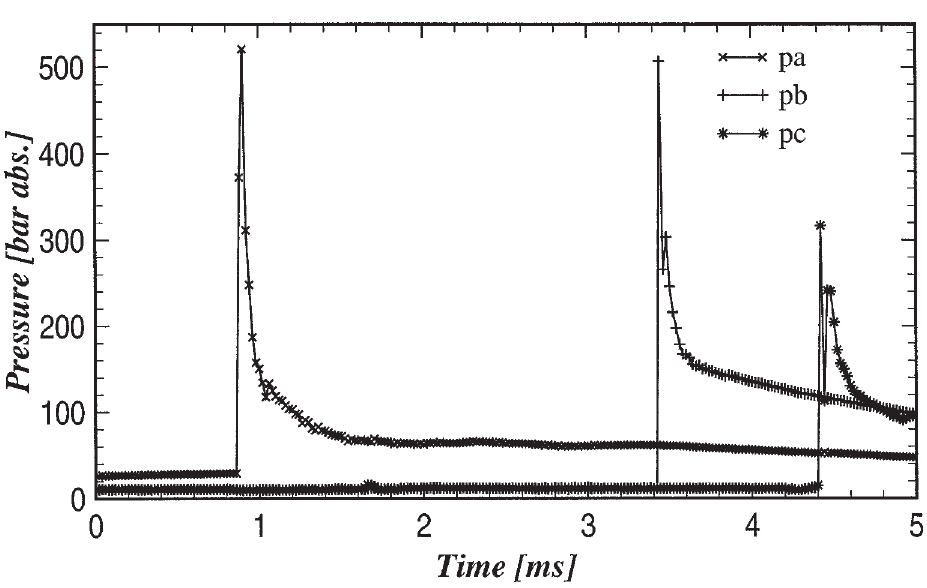
Fig. 2. Pressure/time traces of a detonation propagating through 10 bar acetylene in a (cid:30) i = 6 mm pipe. The pressure sensors p a , p b and p c (type PCB113A03, range 1035 bar, resonance frequency 500 kHz) were mounted in the wall of the tube. p a was mounted most closely to the point of ignition (500 mm). The distances between the sensors were: p a to p b 4410 mm; p b to p c 1750 mm. The sampling interval was 20 (cid:22)